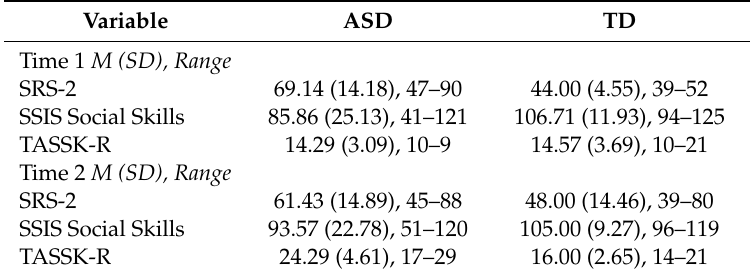
Table 2. Behavioral measures for Time 1 and Time 2 in ASD and TD